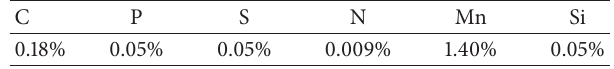
Table 1: Chemical composition of S235 steel